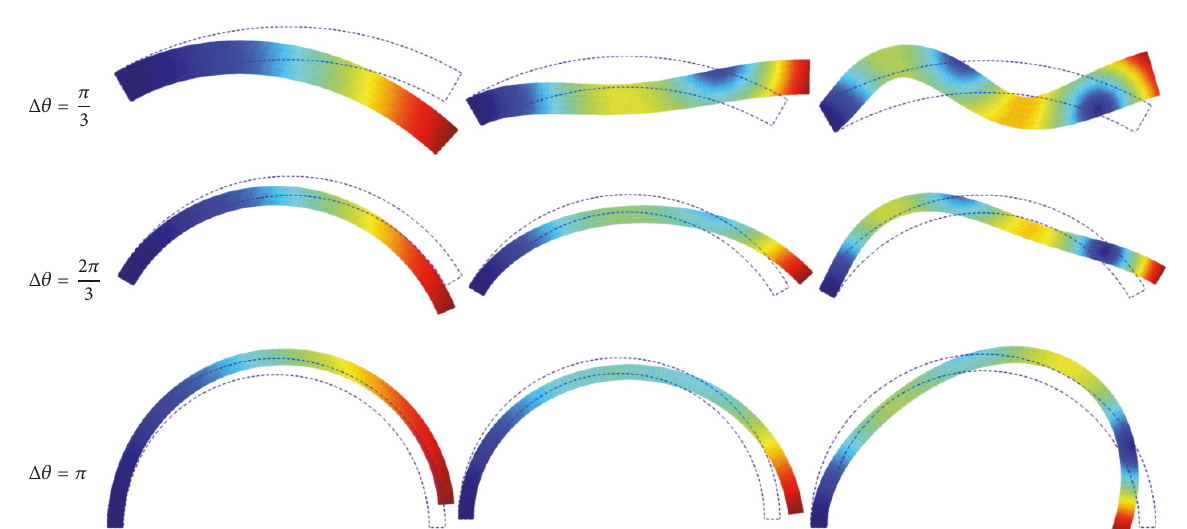
Figure 9: Modal shapes relative to the F-C circular curved beams of Table